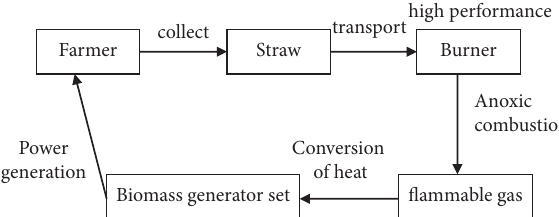
Figure 7: Flowchart of the application planning model of Chongqing rural straw gasification power generation. Chart source: the